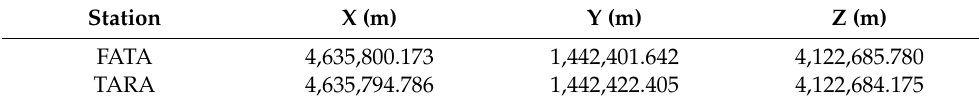
Table 2. Coordinates of FATA (smartphone position) and TARA in the ITRF14